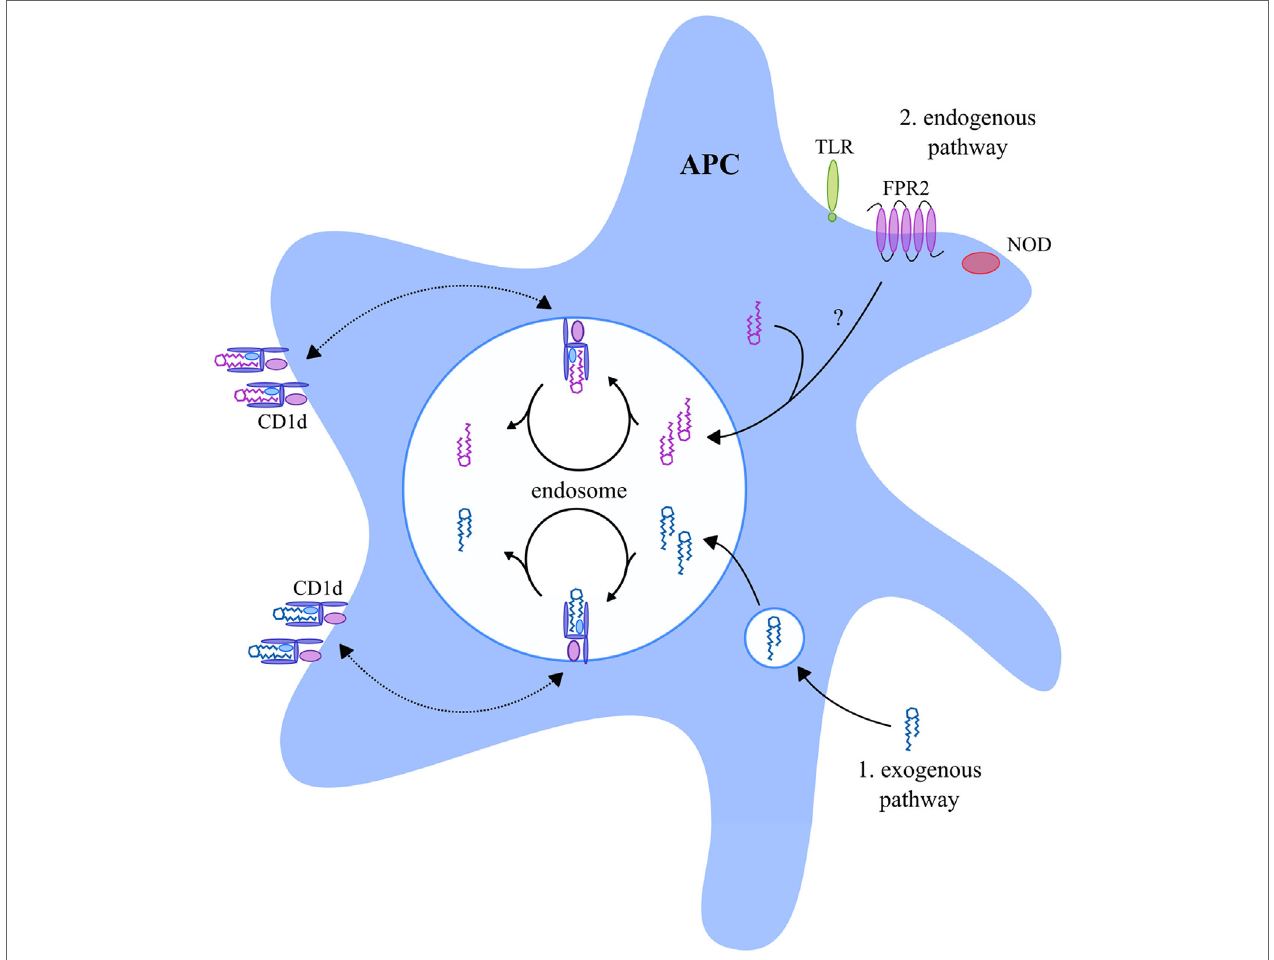
FigURe 2 | CD1d-presented glycolipids in APC. APC present exogenous and endogenous glycolipids in the context of CD1d. During endosomal trafficking, CD1d molecules relocate from the cell membrane toward a late endosome where the bound glycolipid antigens are removed from CD1d and replaced by new glycolipid antigens. Exogenous glycolipids (indicated in blue) enter the APC late endosome via endocytosis or phagocytosis (1). Endogenous glycolipids (indicated in purple) enter the late endosome as a result of NOD, FPR2, or TLR signaling (2), but the exact mechanism is unknown. The exogenous and endogenous glycolipids are loaded into CD1d molecules upon which they relocate back to the cell membrane. Abbreviations: APC, antigen-presenting cells; NOD, nucleotide-binding oligomerization domain; FPR2, formyl peptide receptor 2; TLR, toll-like